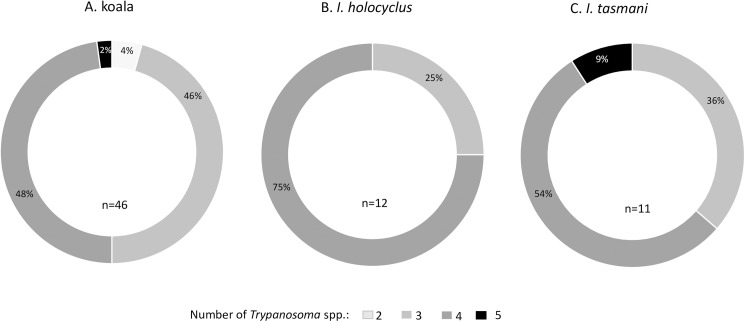
Characterisation of mixed trypanosome infections in koalas (A), Ixodes holocyclus (B) and Ixodes tasmani (C), based on the number of unique trypanosome species involved. Each doughnut chart shows proportions of the total number (n) of samples harbouring more than one Trypanosoma sp., based on the NGS analysis.